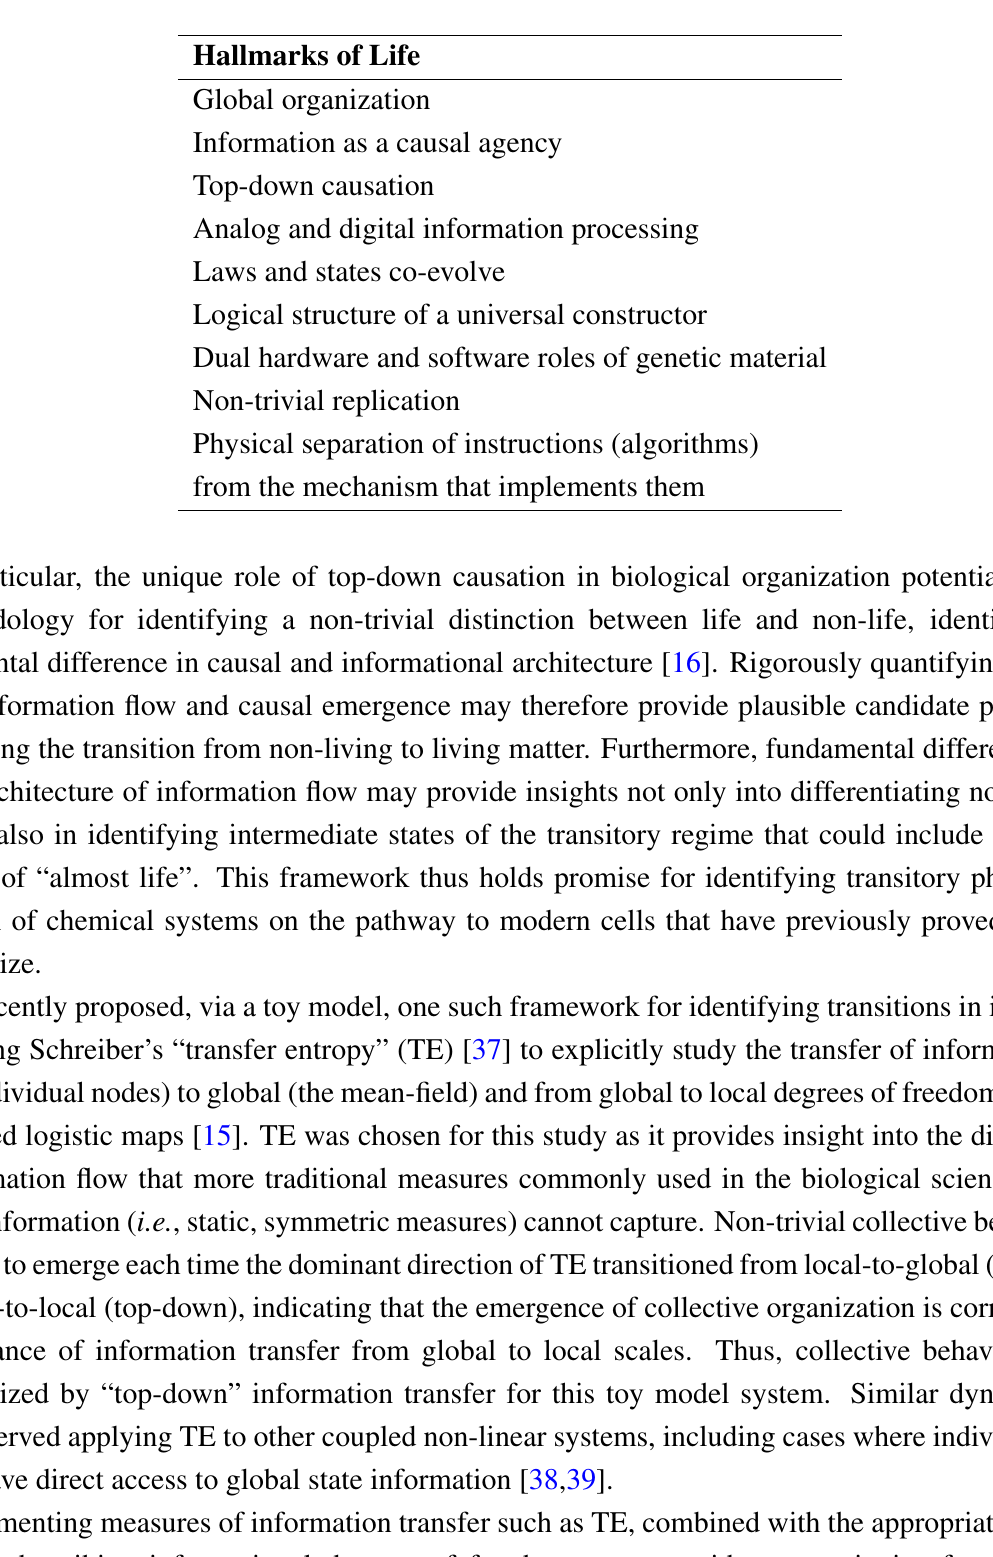
Table 2. The hallmarks of life. Table from Walker and Davies